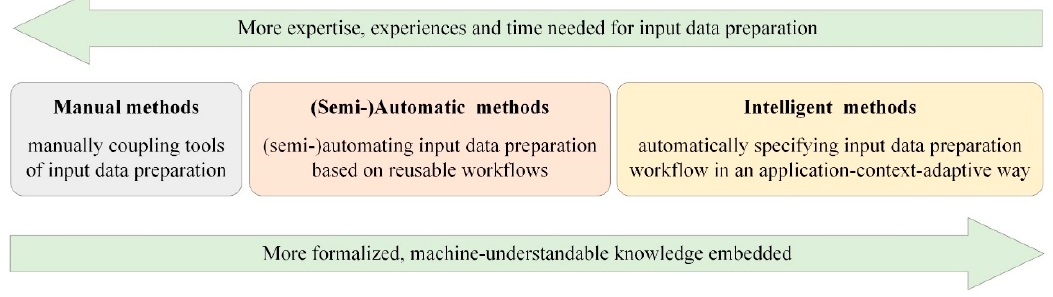
Figure 1. Three categories of input data preparation methods for geographic models.